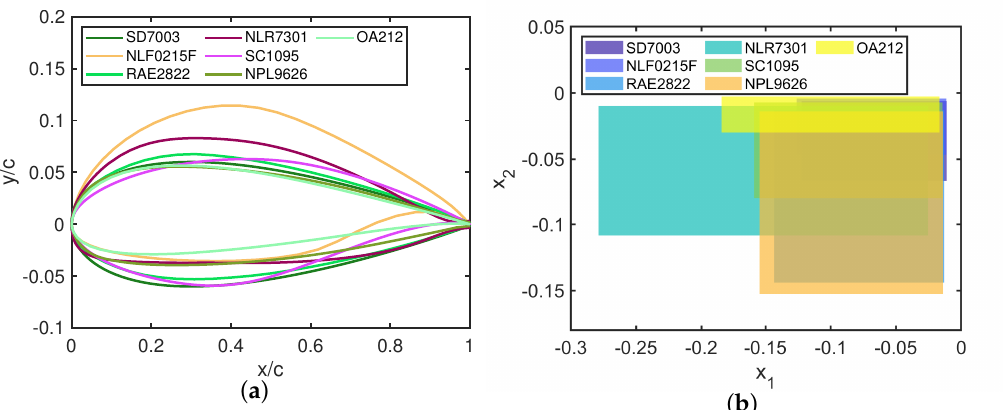
Figure 1. The baseline airfoil classes and part of design space. ( a ) seven baseline airfoils; ( b ) the margin of 2 out of 10 CST